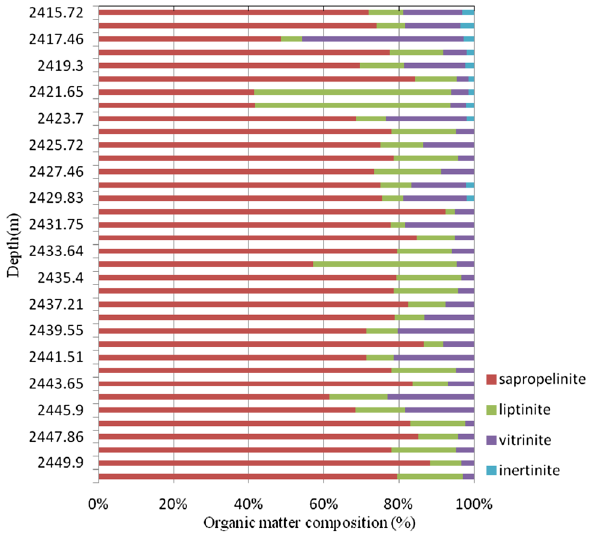
Fig. 3 Composition of organic matter in ORI 5. Sapropelinite is the dominant form of organic